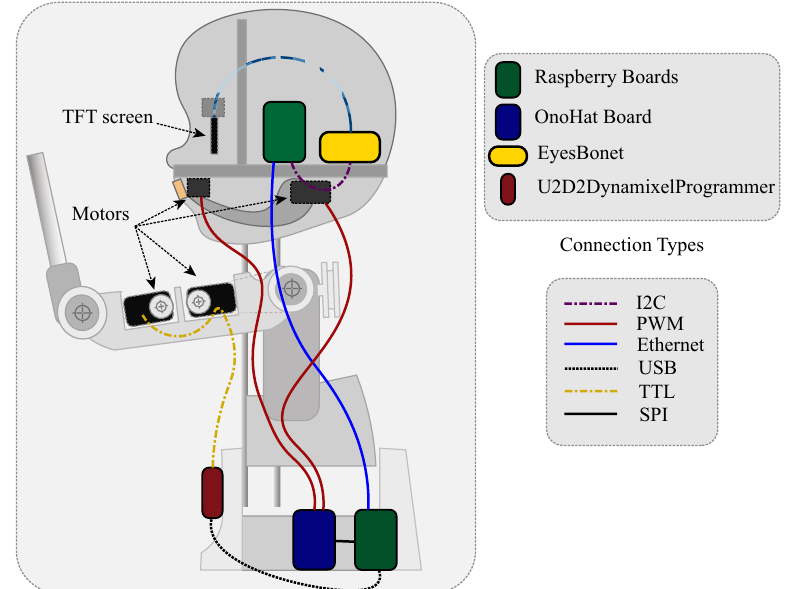
Figure 10. Electronic system, connections, and communication protocols of CASTOR. The right boxes summarize the elements (top) and connection types (bottom) of the robot.